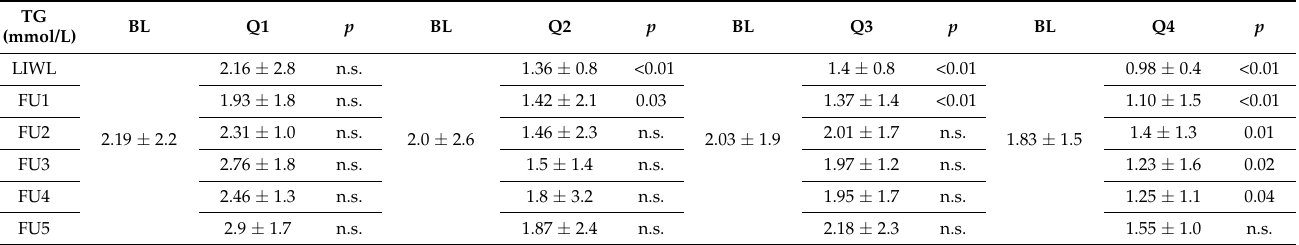
Figure 4. Long-term effects of lifestyle-induced weight loss on parameters of metabolic syndrome in weight loss quartiles (Q1–Q4). Triglyceride (TG) ( a ), HDL cholesterol ( b ), systolic blood pressure (RR sys ) ( c ), and fasting plasma glucose (FPG) levels ( d ) during the 5-year follow-up. Data are presented as the median (interquartile range). BL = baseline; WL = weight loss; 1–5 = years of follow-up. Table 3. Median and interquartile ranges of TG levels before and after LIWL and during the 5-year